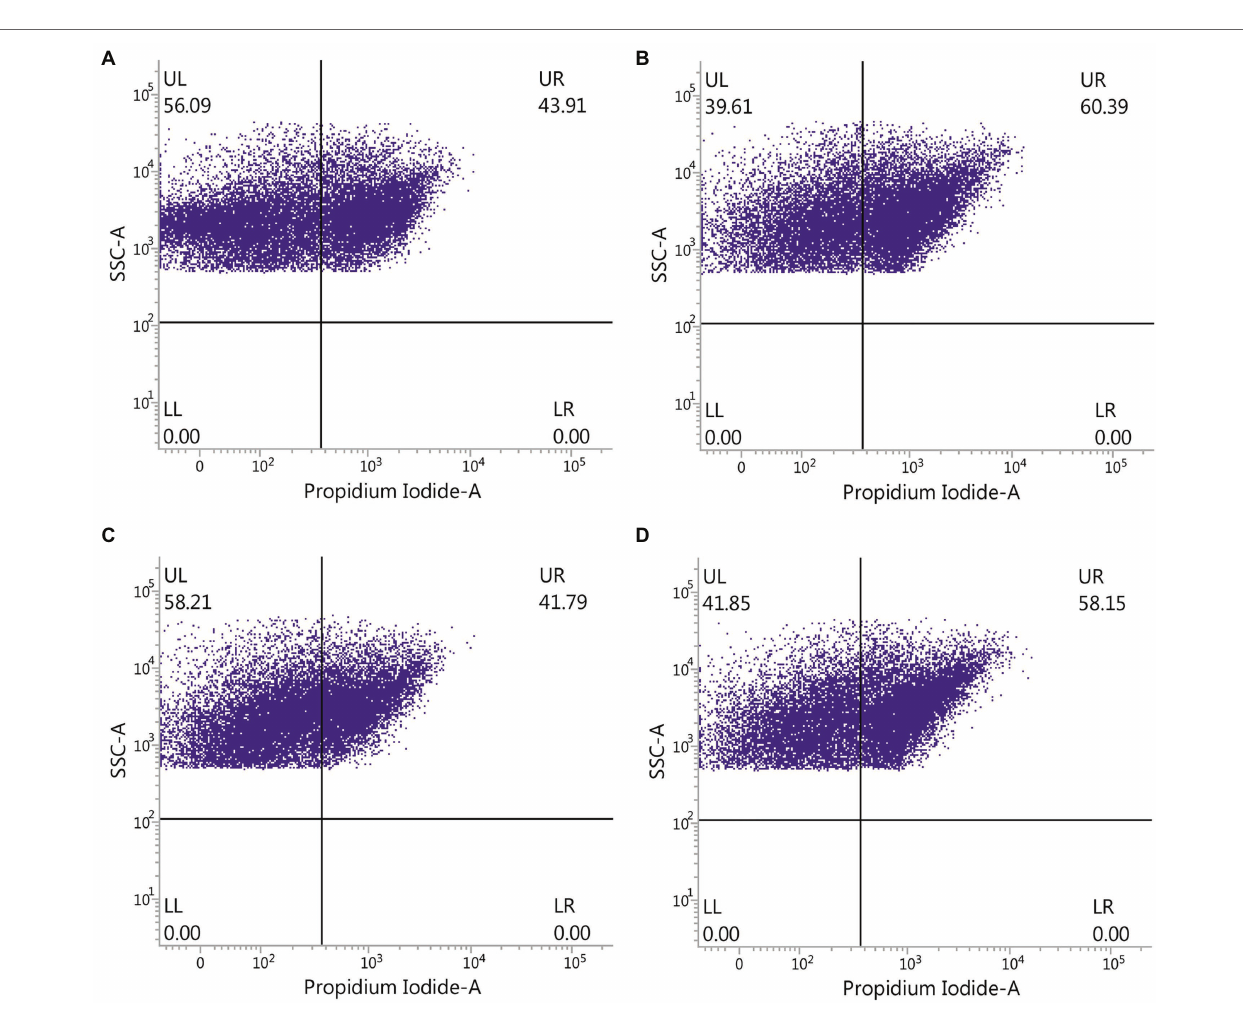
FIGURE 5 | Effect of ZnONP on number of gut bacteria from healthy and ADHD children by flow cytometry observation. (A) Healthy; (B) healthy + ZnONP; (C) ADHD; and (D) ADHD +